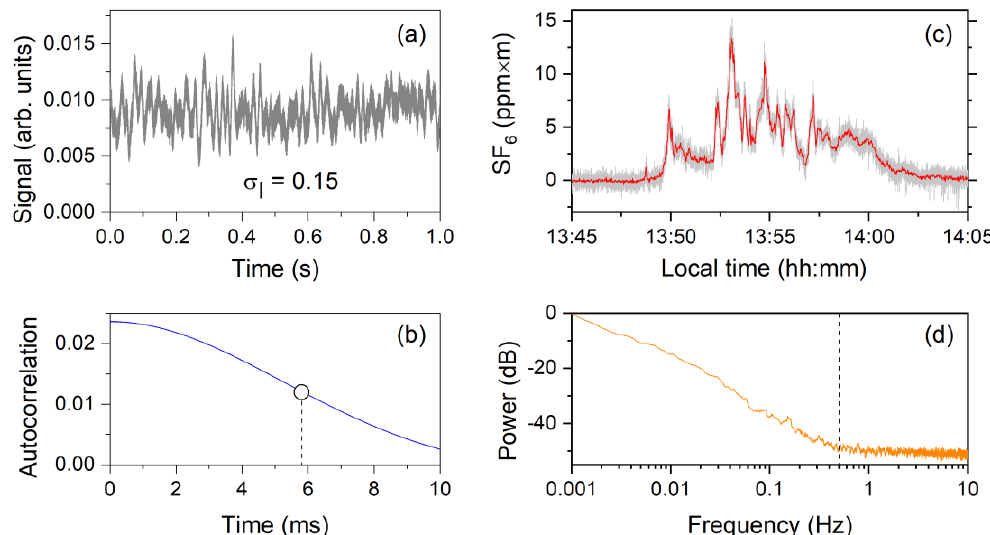
Figure A1. Temporal characterization of atmosphere and plume dynamics using swept-ECQCL. ( a ) Temporal variations in return power at a fixed wavelength over a 1 s time period due to scintillation. The detector signal was digitized at a 500 kHz rate for these measurements, and the calculated scintillation index over this time period was 𝜎 𝐼 = 0.15. ( b ) Temporal autocorrelation of signal in ( a ). The dashed line shows the 3 dB point at 5.8 ms. ( c ) Measured time-resolved column density for SF 6 in the plume release experiment. The light gray trace shows results after averaging to 20 Hz, and the dark red trace shows results after averaging to 1 Hz. ( d ) Fourier transform (power spectrum) of 20 Hz results shown in ( c ). The dashed line shows the frequency (~0.5 Hz) above which the plume has negligible signal power.